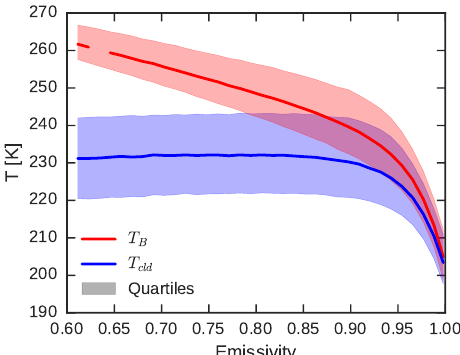
Figure 3. Median and quartiles of maximum (dashed black) and average (solid black) rain rate from AMSR-E, and average vertical winds (solid red) from ERA-Interim, as a function of cloud emis- sivity for high clouds ( p cld < 440hPa) identified from AIRS obser- vations in the tropics, at a spatial resolution of 0.5 ◦ (statistics for January and July